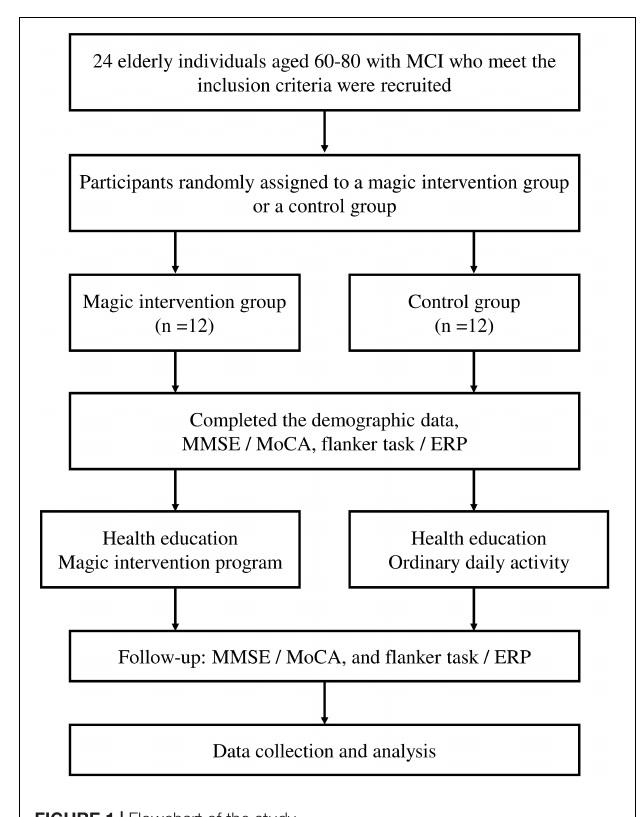
FIGURE 1 | Flowchart of the